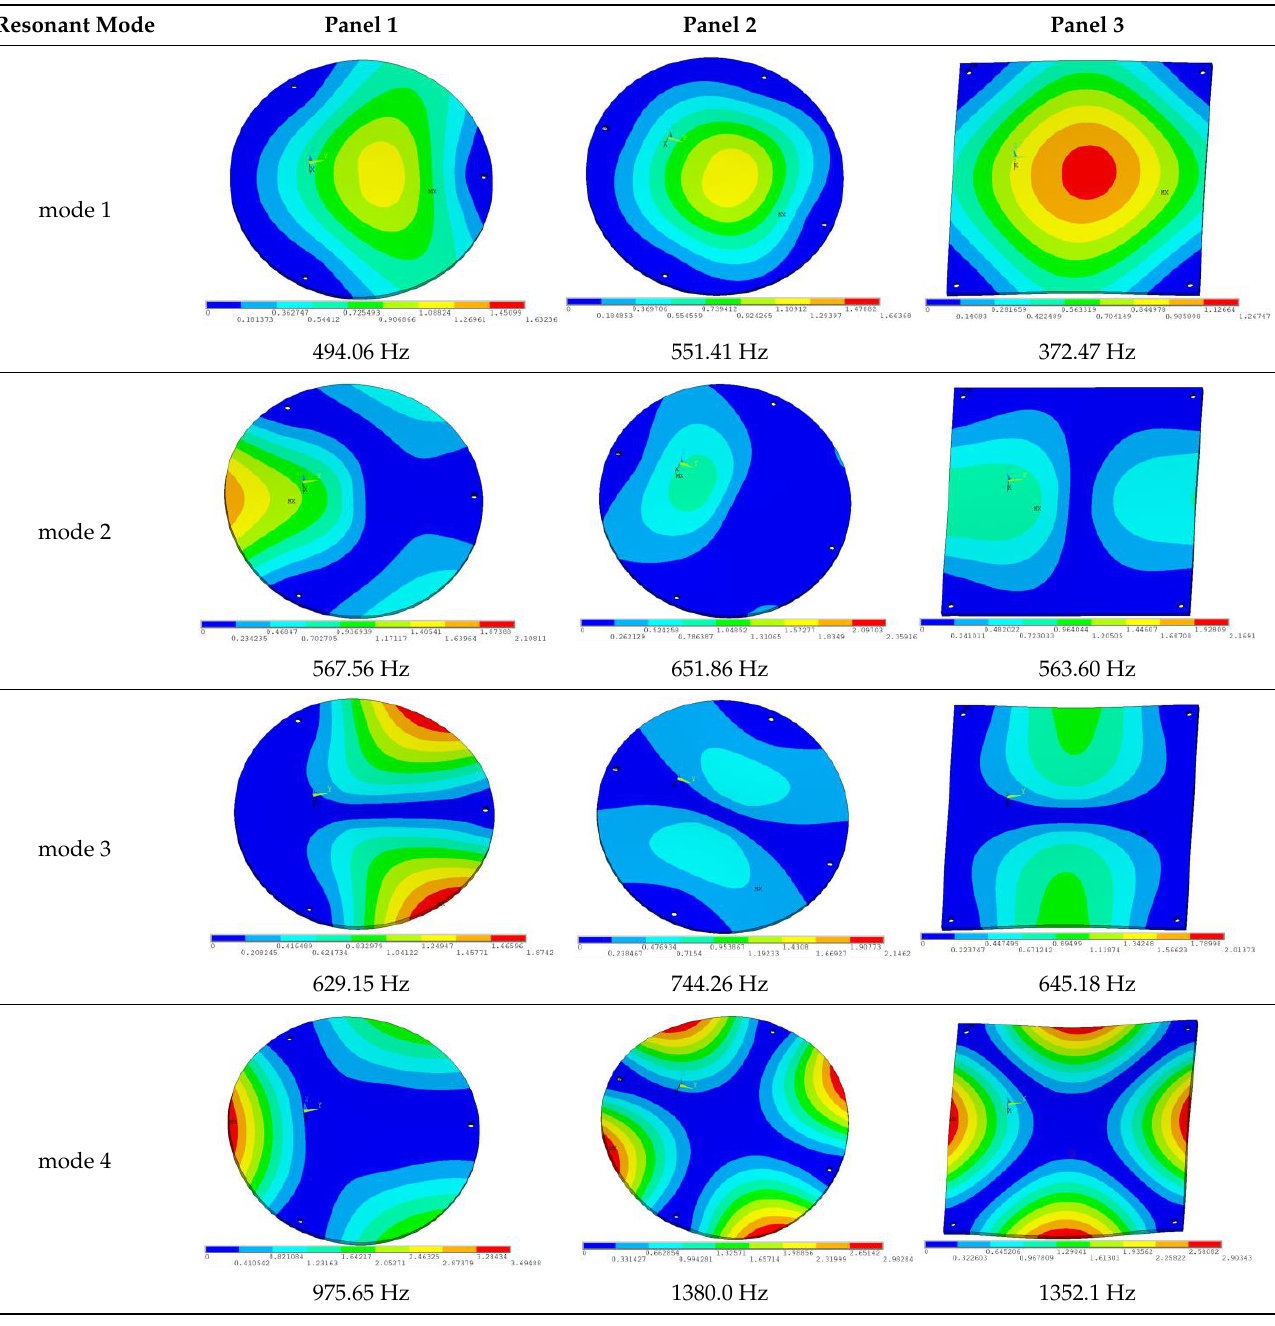
Figure 9. The three basic configurations of the work panel. Meanwhile, this paper only studies the vibration performance of the transducer below 2000 Hz, so only the first eight modes of the transducer are solved, and the modes and resonant frequencies of the three basic configurations are obtained as shown in Table 5. Table 5. The modes and vibration frequencies of three basic configurations.